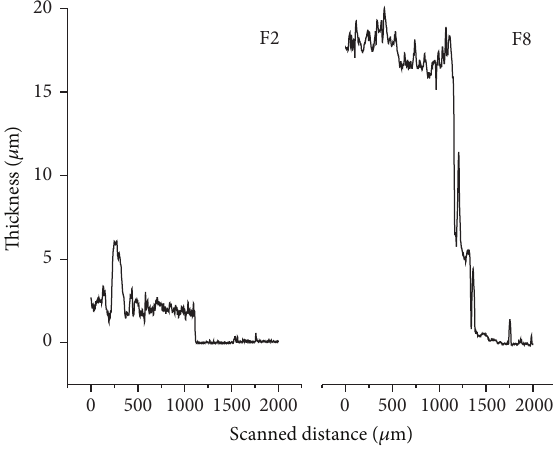
Figure 3: Profilometry of film F2 (2cycles of draining/annealing, 2 h draining time and 450 ∘ C annealing temperature) and film F8 (2cycles of draining/annealing, 3h draining time and 550 ∘ C annealing